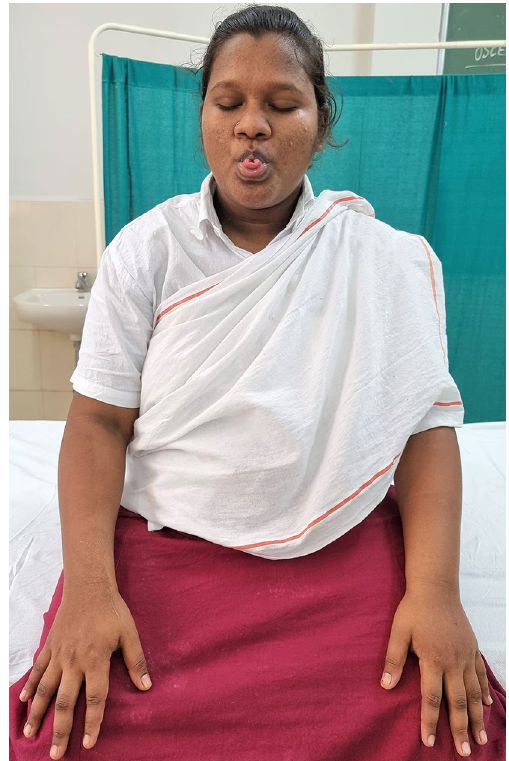
Figure 14. Sheetali or cooling pranayama.